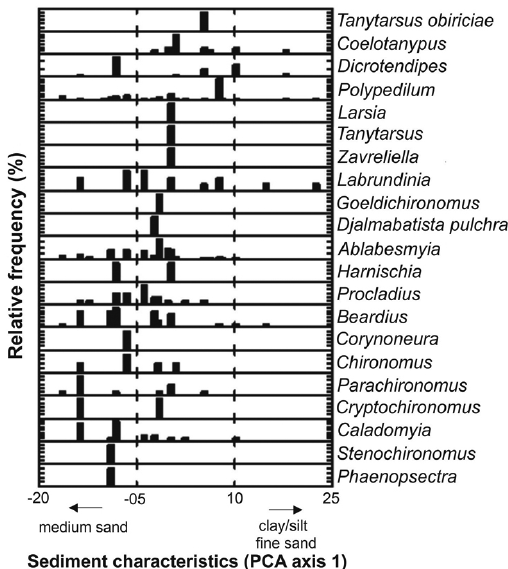
Figura 3. Relative frequency of Chironomidae genera along the gradient in sediment characteristics (PCA axis 1) in a seasonally flooded area of the northern Pantanal,